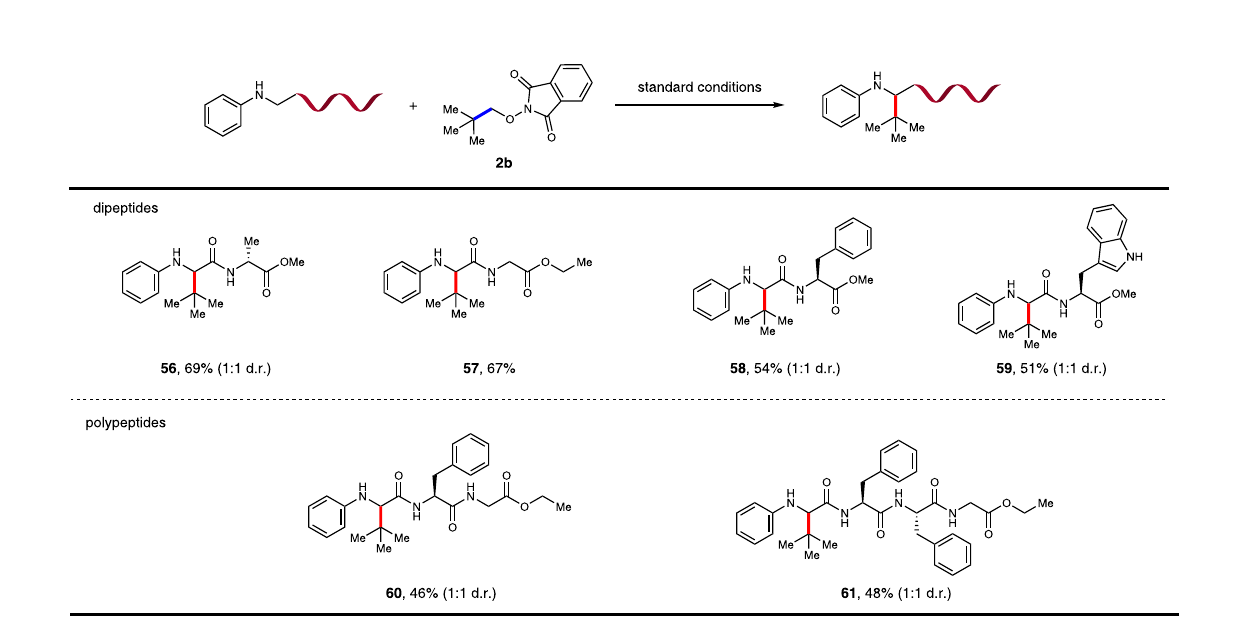
Nature Communications| (2022)